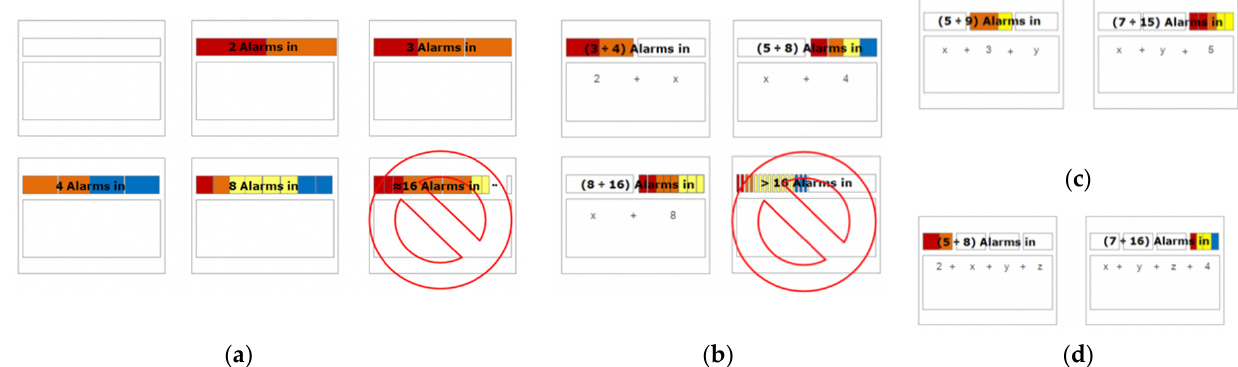
Figure 7. Scalability test of the synthetic component: ( a ) Simultaneous faults in the same NE; ( b–d ) simultaneous faults in two/three/four distinct NEs.